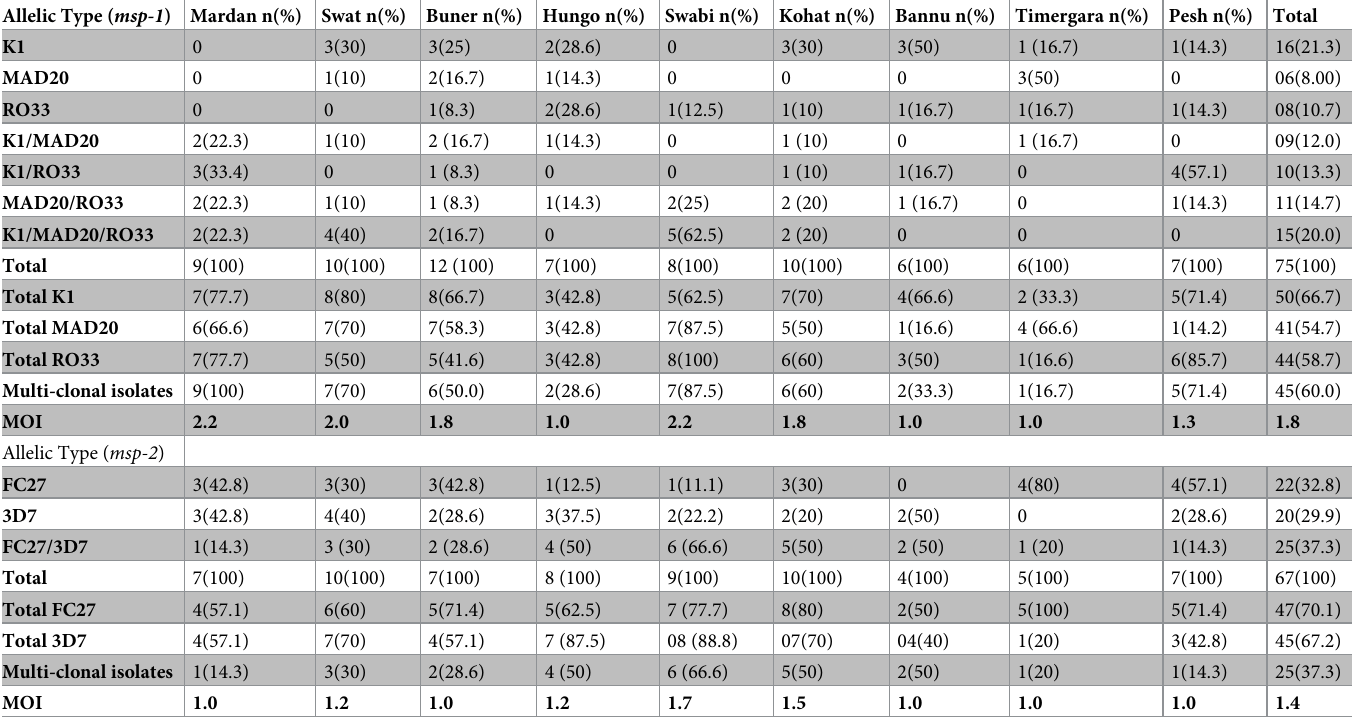
Table 3. Frequencies and MOI of Plasmodium falciparum msp-1 and msp-2 isolates. Allelic Type ( msp-1 ) Mardan n(%) Swat n(%) Buner n(%) Hungo n(%) Swabi n(%) Kohat n(%) Bannu n(%) Timergara n(%) Pesh n(%)